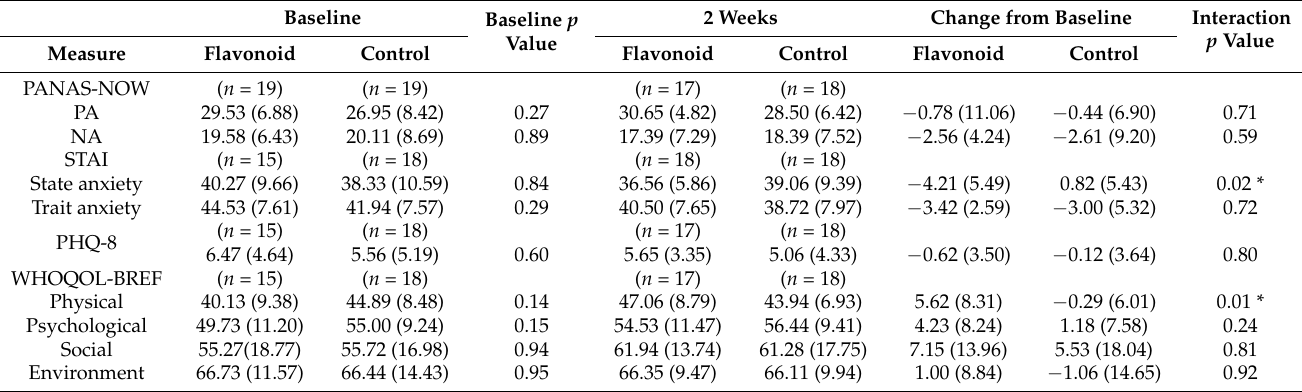
Table 3. Mean (SD) raw outcome variable data for participants in the flavonoid and control groups at baseline and 2-weeks